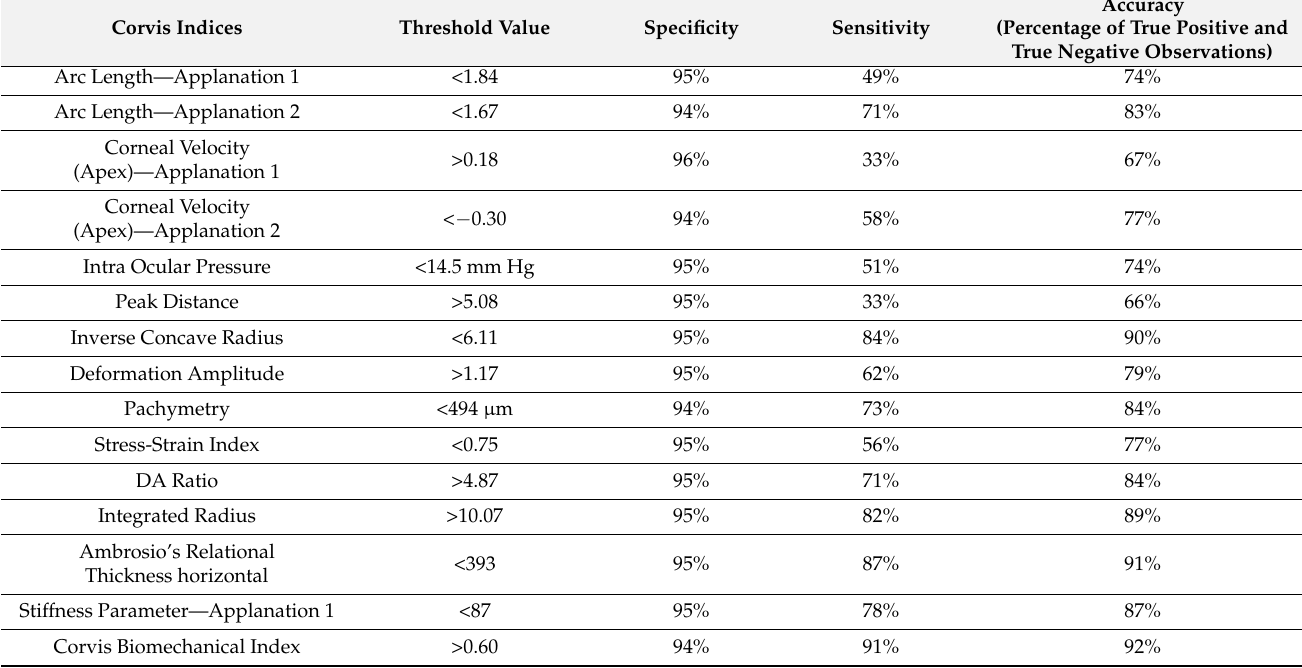
Table 3. Assessment of Corvis indices for the diagnosis of keratoconus.